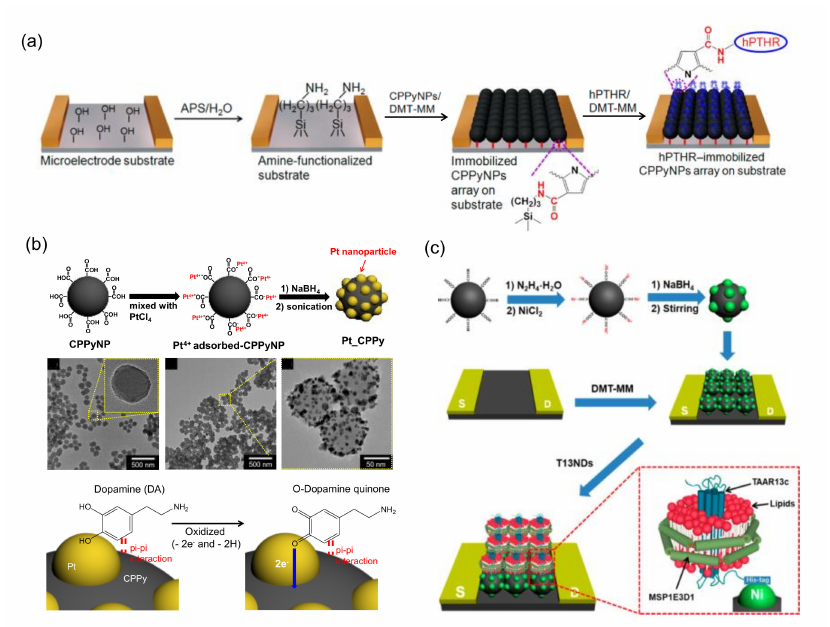
Figure 1. ( a ) Schematic of CPPy nanoparticle-based biosensor electrodes for the detection of